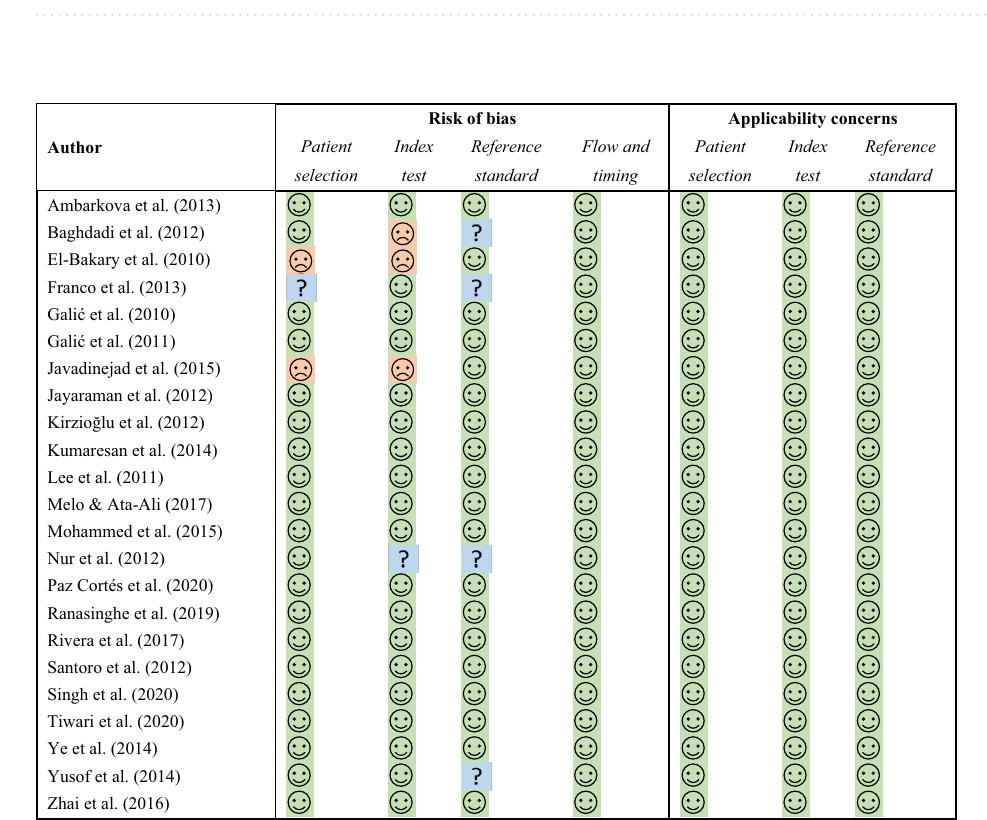
Table 1. The studies included in the meta-analysis. All studies reported the type of examination as “orthopantomography” except two 52,54 . *Wrist and hand X-ray; §The ICC variance was estimated using the formula reported in Noble et al. 65 .